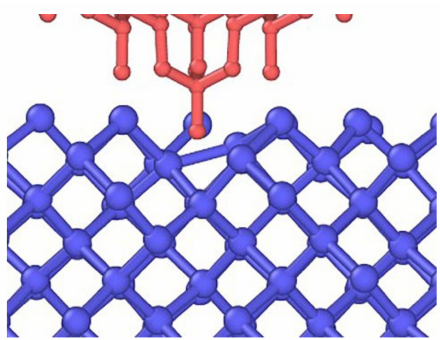
Figure 10. Bond structure when the stroke reaches 0.02 nm.